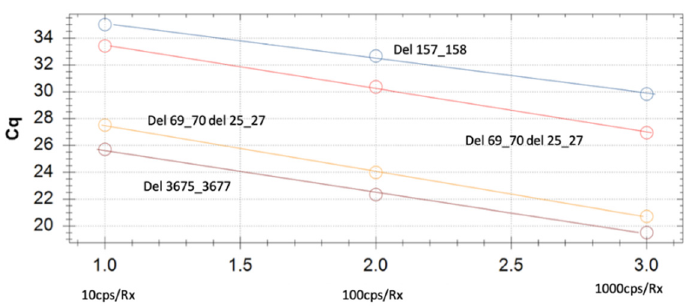
Figure 4. Sensitivity test of our assay.